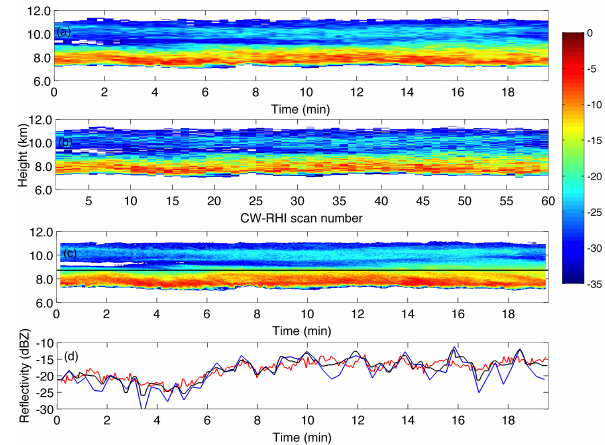
Fig. 8. Time–height radar reflectivity field of a cirrus observed at the SGP with the (a) Ka-SACR gridded ( x = 0m), (b) Ka-SACR post- processed polar coordinates ( θ = 0 ◦ ), and (c) profiling KAZR. The black line indicates the height of panel (d) retrievals. (d) Time series of radar reflectivity from Ka-SACR gridded ( x = 0m, black), Ka- SACR post-processed polar coordinates ( θ = 0 ◦ ; blue) and profiling KAZR